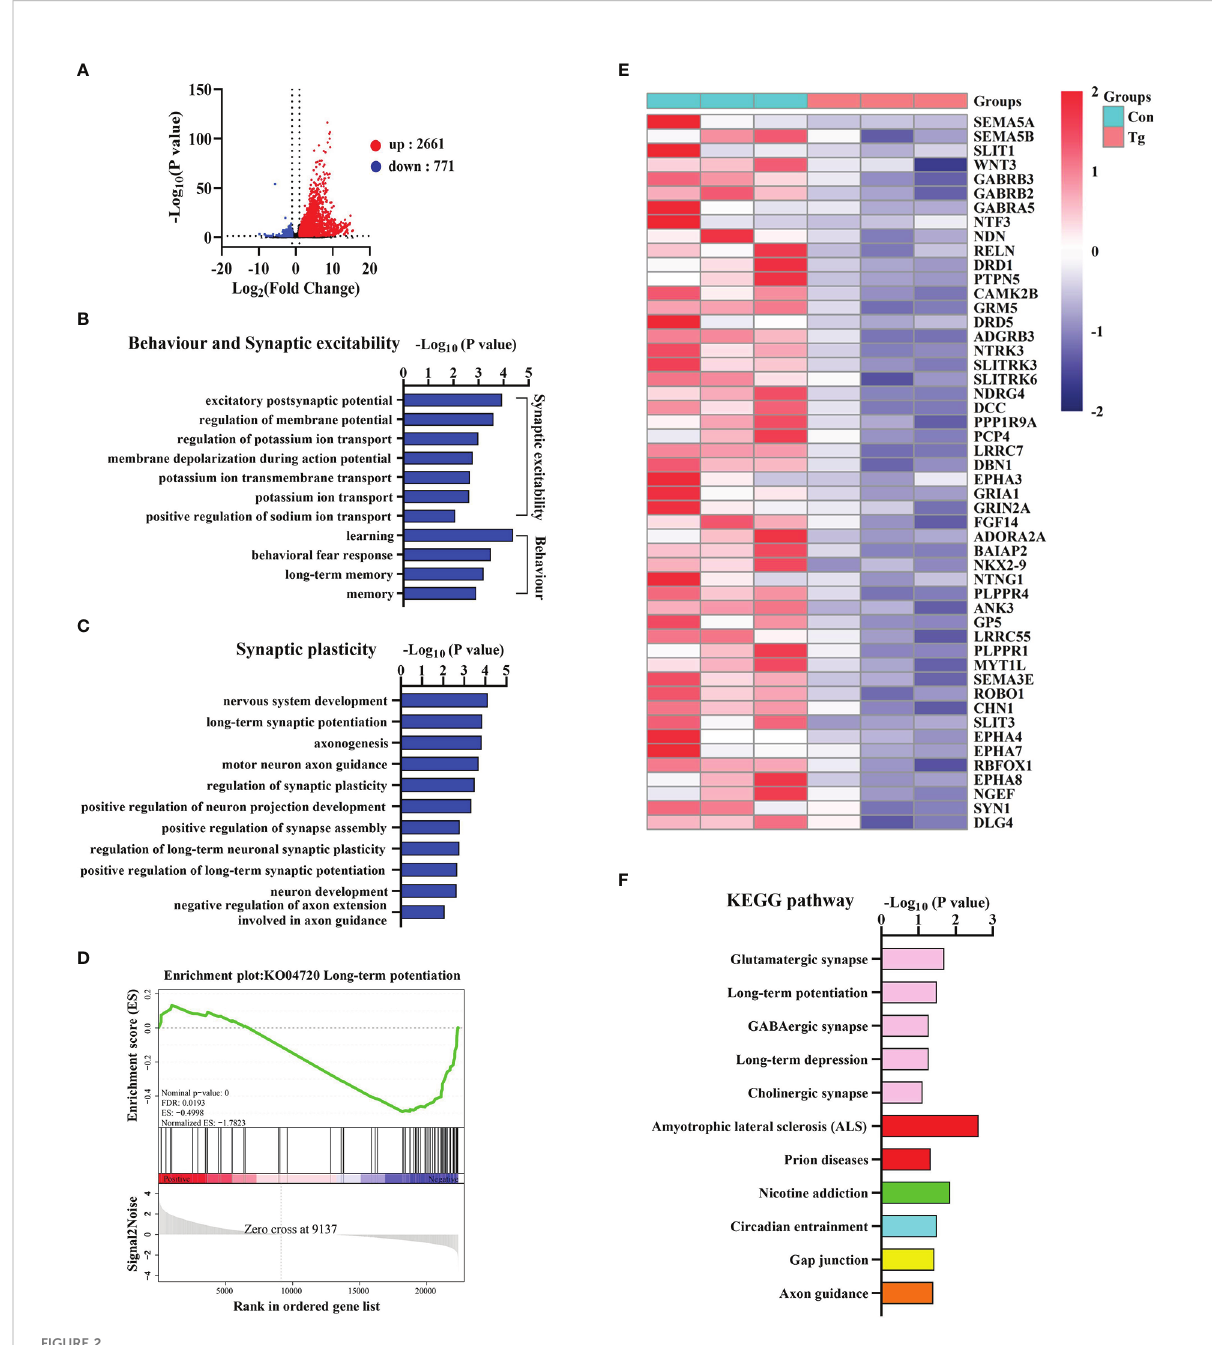
FIGURE 2 T. gondii chronic infection disturbs the expression of genes related to cognition, synaptic plasticity and transmission in the hippocampus of mice. (A) The volcano plot shows the distributions of differentially expressed genes (DEGs) between Con and Tg mice. (B) The biological processes associated with behavior and synaptic excitability are downregulated in T. gondii infected mice. (C) The biological processes associated with synaptic plasticity are downregulated in T. gondii infected mice. (D) GSEA analysis revealed that genes involved in long-term potentiation were signi fi cantly downregulated. (E) Heatmap demonstrating the relative expression of core genes in the enrichment plot ( n = 3) are upregulated in Tg group in comparison to Con group. (F) The enriched KEGG pathways related to axon guidance and synapse related pathways in T. gondii infected mice. Columns with different colors represent different classi fi cation in level 2. Con, control mice; Tg, T. gondii infected